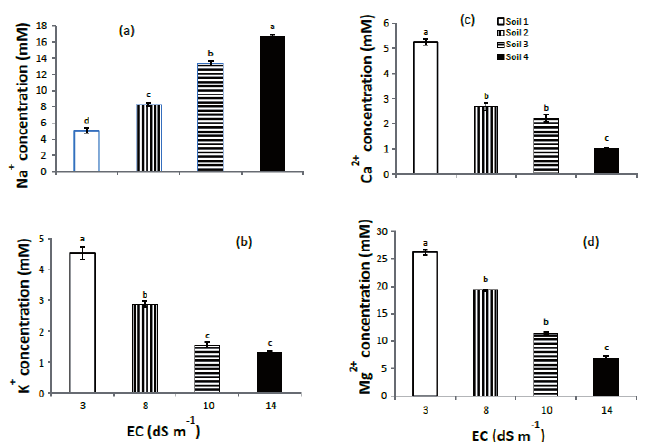
Fig. 3: Na + concentration mM (a), K + concentration mM (b), Ca 2+ concen- tration mM (c), and Mg 2+ concentration mM (d) as influenced by the increasing EC level of the soil samples, Different letters indicate significant differences between the treatments at P < 0.05 (n ≥ 3).